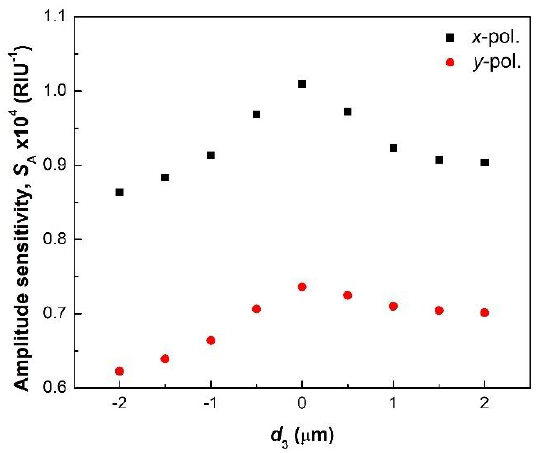
Figure 11. Amplitude sensitivity as a function of d 3 . Black points (square shape) and red points